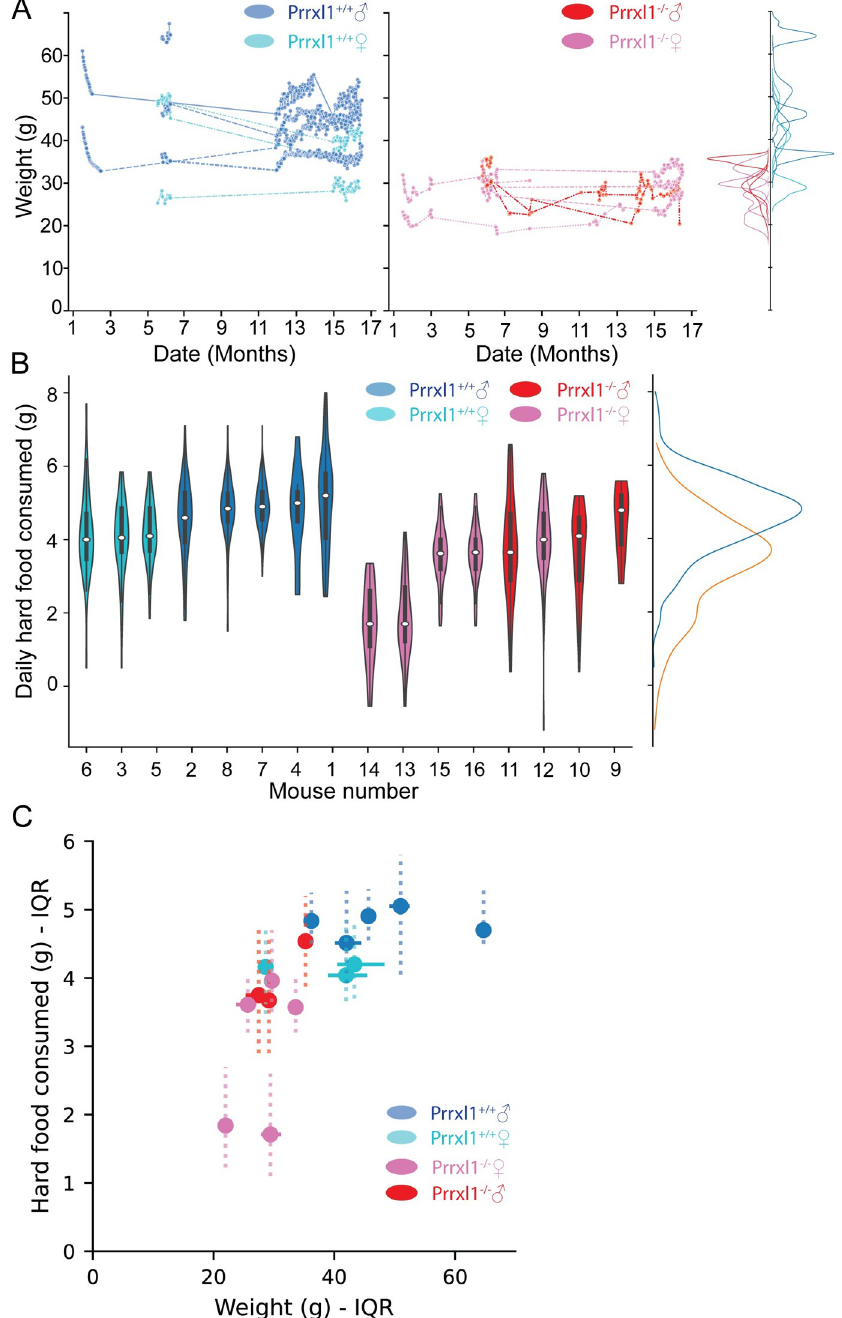
Fig 2. Body weights and daily food intake of WT and KO mice. Data are shown for days of unrestricted access to hard food and water with at least 5 preceding consecutive ad lib water days. (A) Comparison of weights for WT and KO mice over a 17 month period. Wildtype mice (left panel, blue hues) consistently maintain higher body weights than KO mice (right panel, red hues). Data are colored by sex in this and all subsequent panels. Only one WT animal overlaps with the KO population (individual distributions as inset on far right. WT = blue/right, KO = red/left). (B) On average, KO mice (red distributions, right side) consumed less hard food than wildtype mice (blue distributions, left side): WT 4.66 ± 1.03 g, Prrxl1KO 3.41 ± 0.32 g; mean ± std, p = 0.006, two-sided T-test. Six out of eight KO animals have means equal to or lower than the lowest WT. Interquartile ranges are plotted as dark bars. Population distributions plotted as inset on the far right using the same color scheme. (C) Relationship between weight and food consumed. Means and interquartile ranges are shown for both variables. None of the subgroups (e.g., male WT,